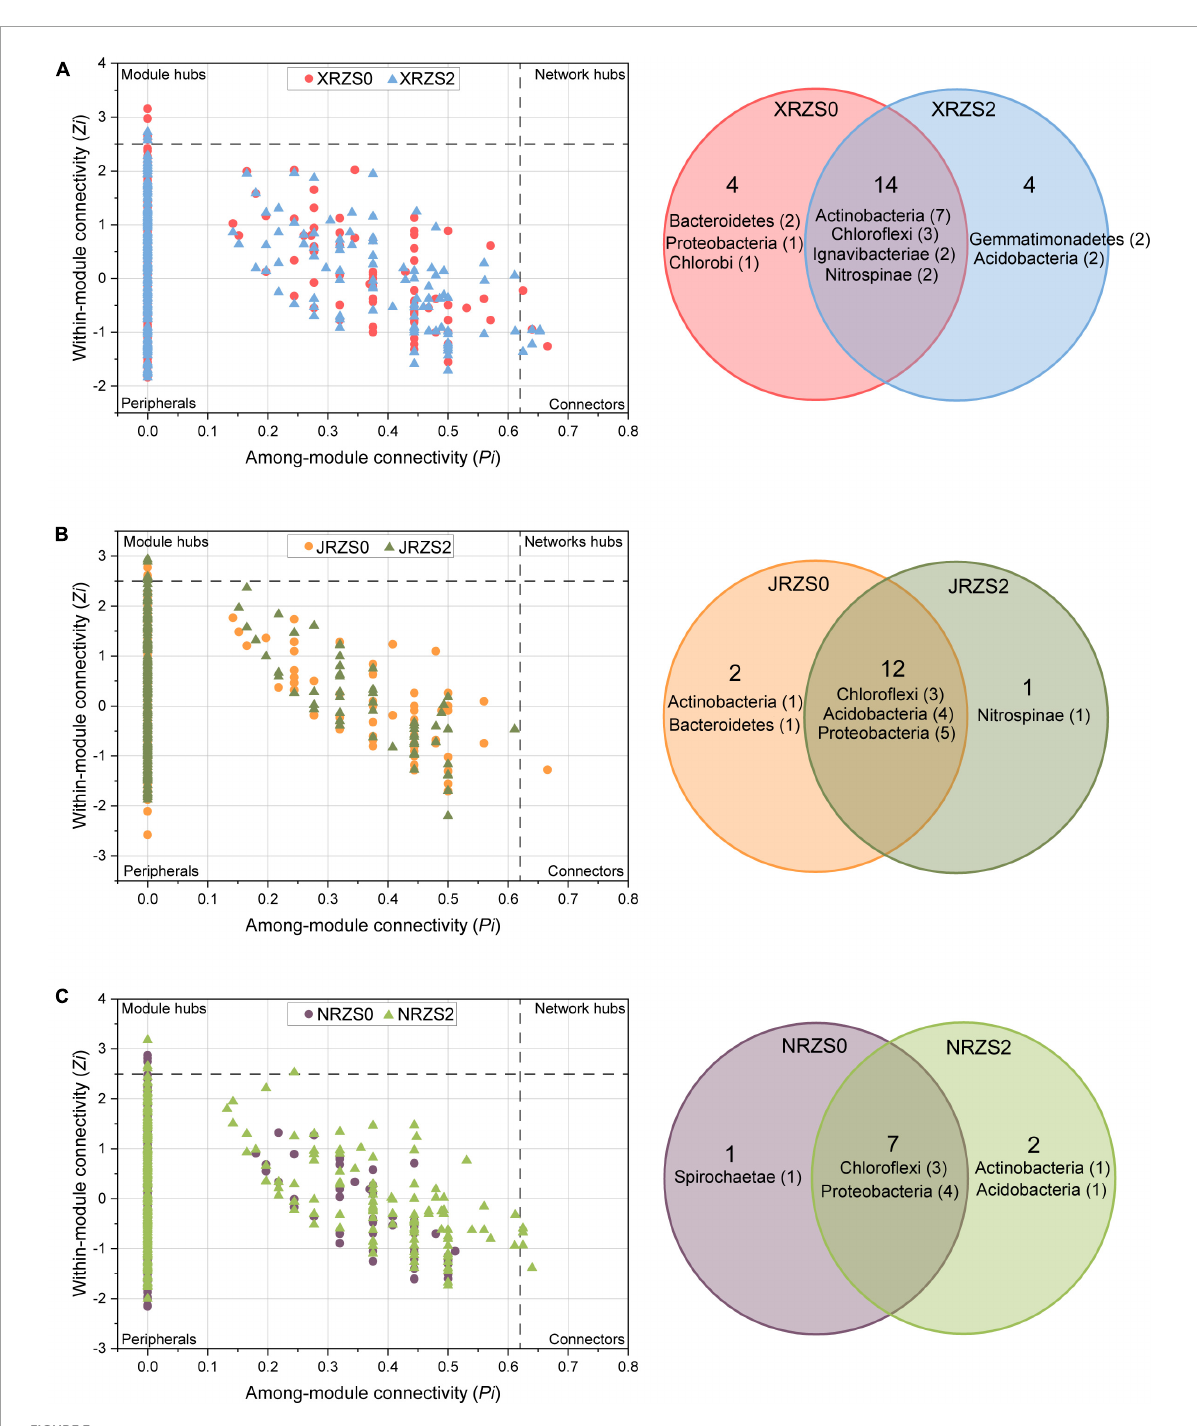
FIGURE3 Z i - P i plot showing the distribution of OTUs based on their topological roles representing an OTU with (ZS2, triangle) or without (ZS0, circle) basal zinc fertilizer. The threshold values of Z i and P i for categorizing OTUs are 2.5 and 0.62. The Venn diagram shows the similarities and differences between keystone hubs in networks between two treatments. (A) HHZ; (B) NJ9108; and (C)